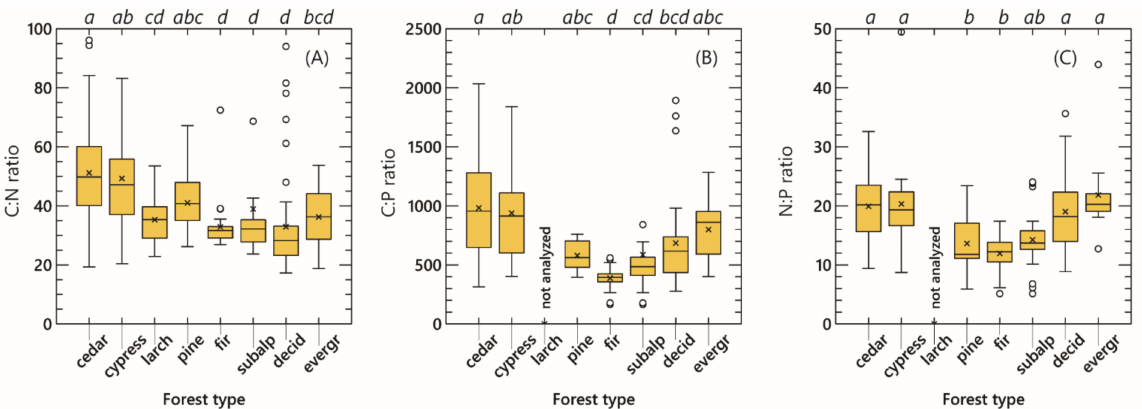
Figure 4. Box and whisker plots of stoichiometry (C:N ( A ), C:P ( B ), and N:P ( C ) ratios) of the forest floor among Japanese forest types. The definitions of box and whisker are the same as those used in Figure 2. Different lowercase letters on the figure denote significant differences between forest types at p < 0.05 by the Steel–Dwass